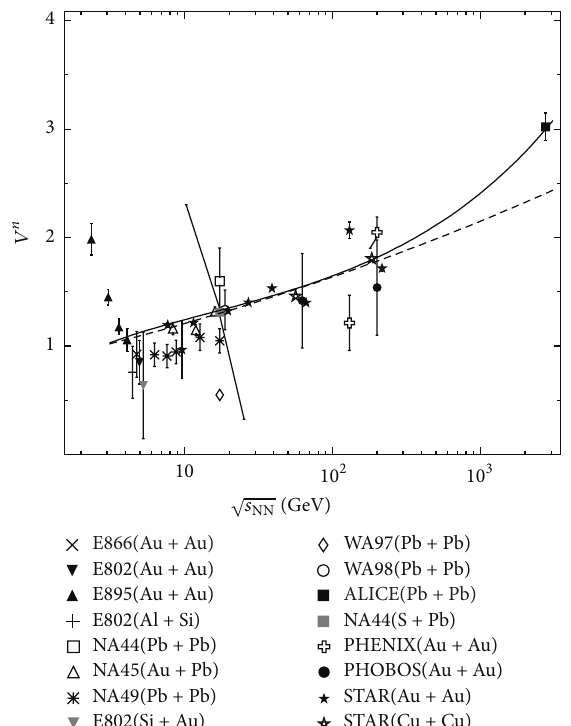
Figure 6: Energy dependence of scaled volume of emission region at freeze-out for secondary charged pions in various nucleus- nucleus collisions at ⟨𝑘 ⊥ ⟩ ≃ 0.2 GeV/ 𝑐 . Equation (3) is used for calculation of volume values. Experimental results are shown for the same collision, particle, and Coulomb correction types as well as in Figure 4. Error bars are only statistical (for NA44, total uncertainties). Smooth curves are derived from(3) and the fit results for 𝑅 𝑛 𝑠 , 𝑅 𝑛 𝑙 . The solid line corresponds to the fits of scaled HBT radii by function (7) and dashed line to the fits by specific case 𝑅 𝑛 𝑖 ∝ ln 𝜀 , 𝑖 = 𝑠, 𝑙 .